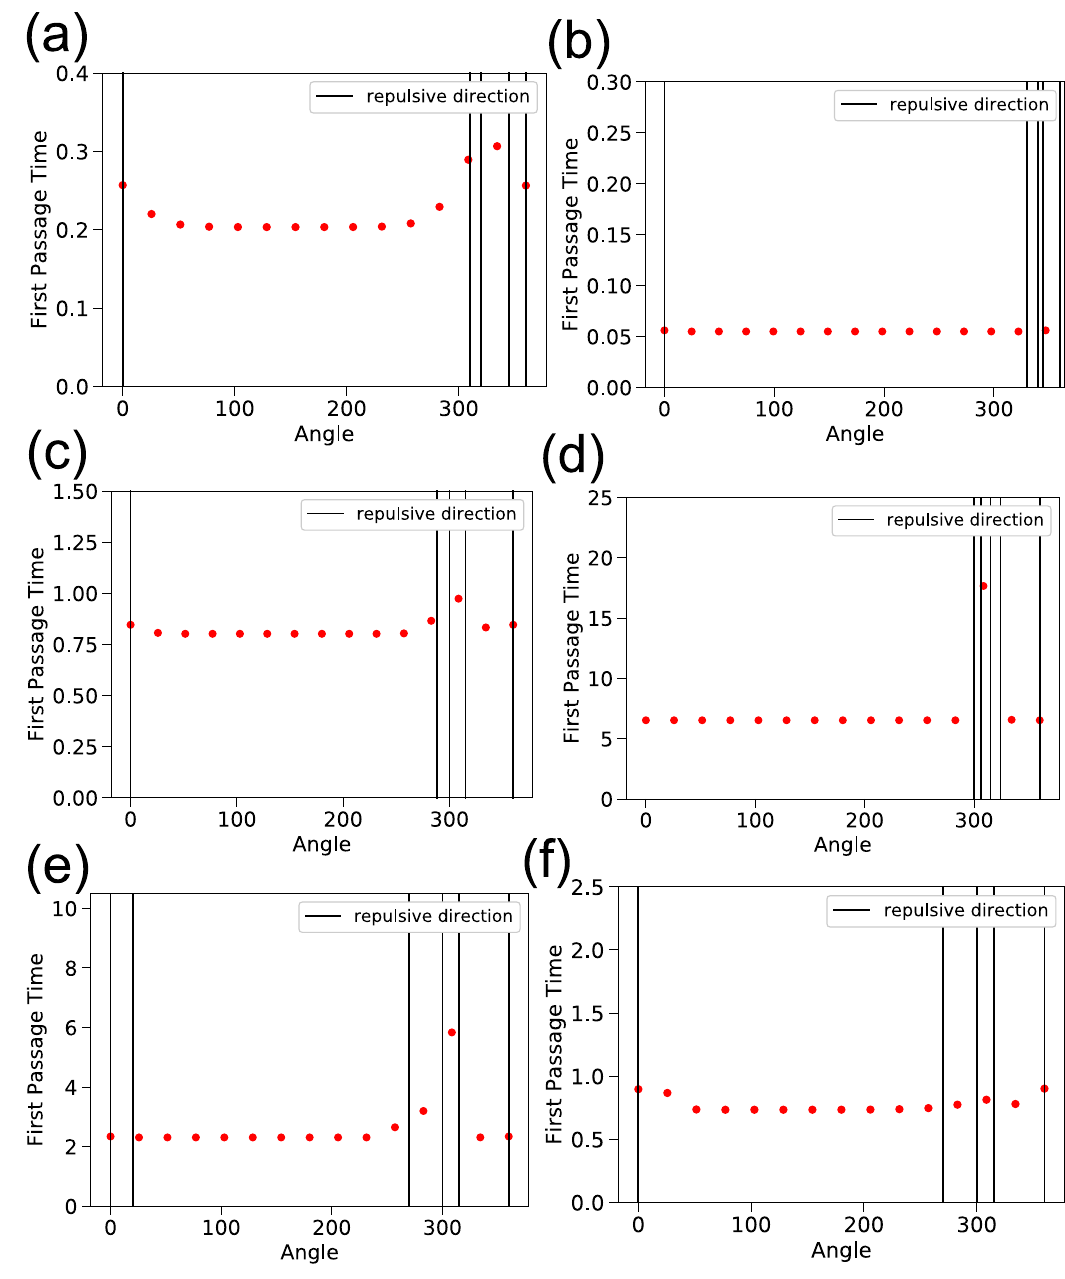
Figure 6. First Passage Times (in hours) for individual hornbills closer to the edge of their home ranges, for different angles. (Vertical) Black lines indicate repulsive directions. Distances r from the home range centre are respectively: ( a ) GH1Br, r = 1.8 ( b ) GH3Br, r = 0.74 ( c ) GH4Br, r = 3.16 ( d ) GH2NBr, r = 9.28 ( e ) GH5NBr, r = 5.11 ( f ) WH1Br, r = 7.00 km. Also see Supplementary video SI Fig.